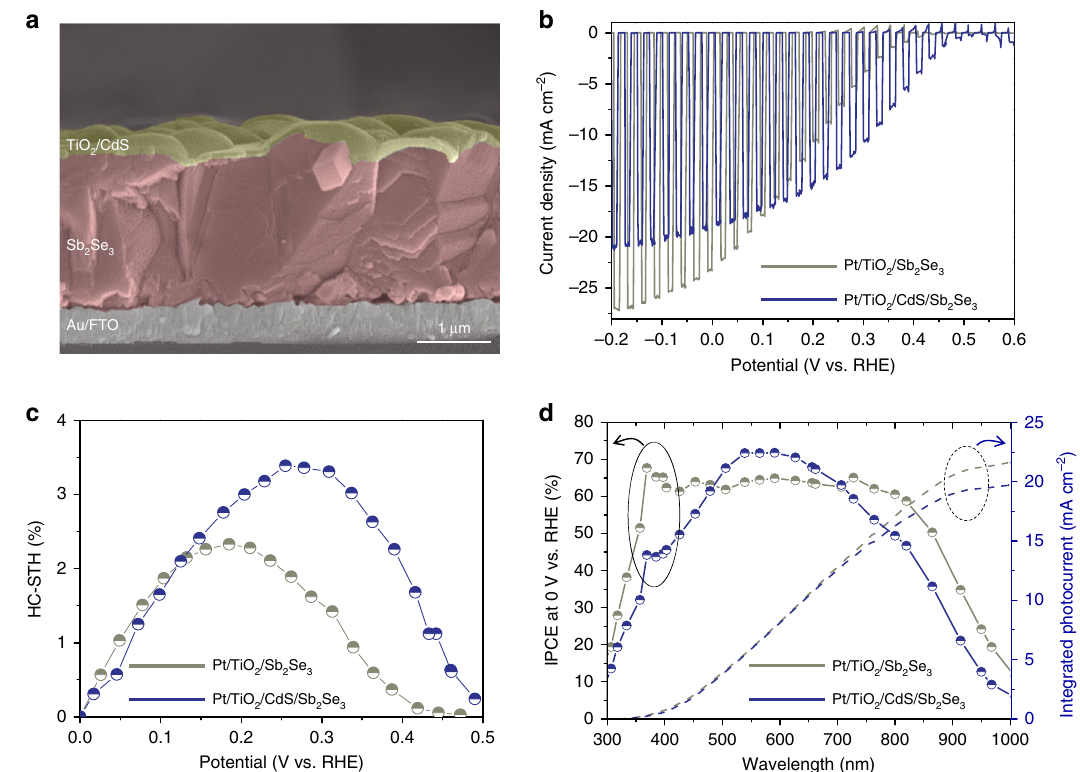
Fig. 4 Microstructure and PEC performance of Pt/TiO 2 /CdS/Sb 2 Se 3 /Au/FTO photocathodes. a Cross-sectional SEM image of TiO 2 /CdS/Sb 2 Se 3 on Au/FTO substrate. b J – V curves for Sb 2 Se 3 photocathodes with/without a CdS layer in pH 1 H 2 SO 4 under simulated 1 sun air mass 1.5 G chopped illumination at a scan speed of 5 mV s − 1 from positive to negative potential and c corresponding HC-STH ef fi ciencies. d Wavelength-dependent IPCE at 0 V RHE of Sb 2 Se 3 photocathodes with/without CdS layer. Source data used to generate this fi gure can be found in the Source Data fi